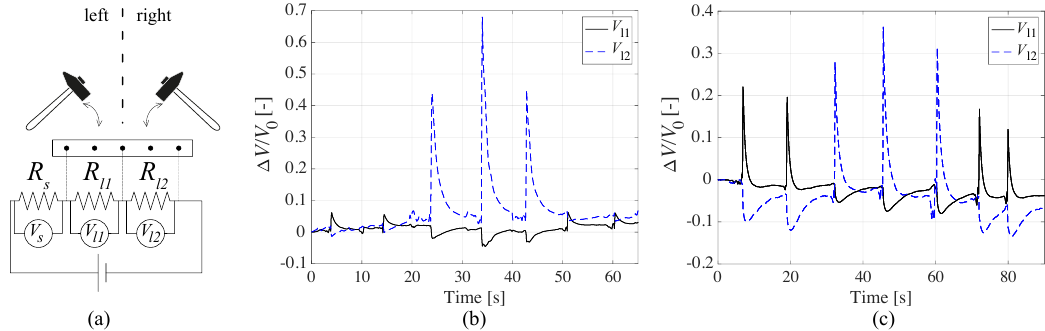
Figure 6. The sketch of the experiment ( a ) and the voltage pulses generated during two hammer-impact test sequences ( b , c ).